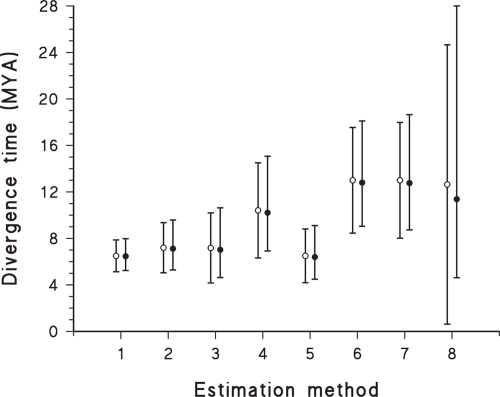
Divergence time estimates (million years ago) for the gorilla—human split (using the human—orangutan split as the calibration time) based on eight different estimation methods, which produce different coefficients of variation (CV), and using the arithmetic (open symbols) and geometric (filled symbols) means and 95% confidence intervals. The methods are 1–2: protein gamma distance (Glazko and Nei, 2003), with 1 = concatenated sequences, 2 = individual sequences; 3–4: bayesian (Aris-Brosou and Yang, 2002), 3 = molecular clock, 4 = non-clock; and 5–8: maximum likelihood (Aris-Brosou and Yang, 2002), 5 = molecular clock, 6 = two rates, 7 = three rates, 8 = four rates. For method 1 CV ≈ 10%, for methods 2, 5 CV ≈ 15%, for methods 3, 4, 6, 7 CV ≈ 20%, and for method 8 CV ≈ 50%.